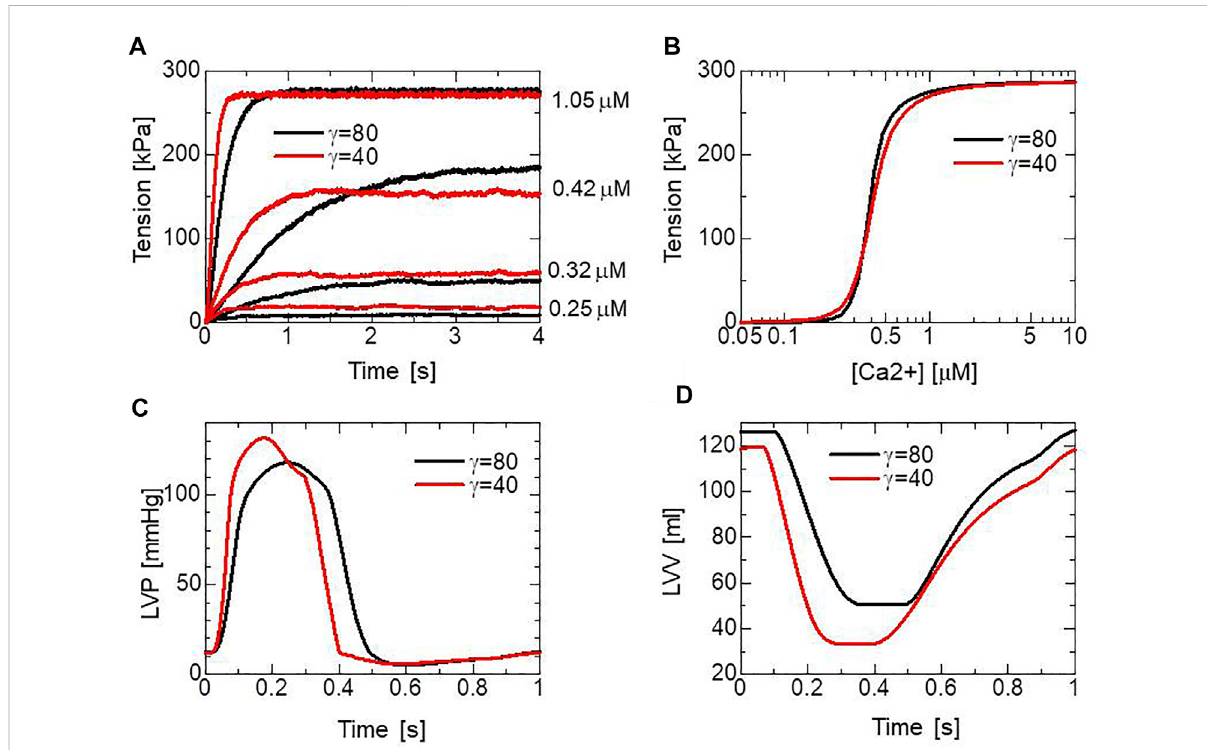
FIGURE 5 ThesimulatedpCa-tensionrelationshipoftheMCcross-bridgemodelanditseffectsonheartpumping. (A) Timecoursesoftheactive tensions in the isometric contraction for [Ca 2+ ] = 0.25, 0.42, and 1.05 μ M with γ = 80 (black) and γ = 40 (red). (B) Isometric tensions in the equilibrium states averaged over the time interval [3.5 s, 4 s] with γ = 80 (black) and γ = 40 (red). The half-sarcomere length was fi xed at 1.14 μ m ( λ (cid:2) 1 . 2). (C) Time transients ofleftventricularpressures(LVP)with γ =80(black)and γ =40(red). (D) Timetransients oftheleftventricularvolume(LVV)with γ =80 (black) and γ = 40